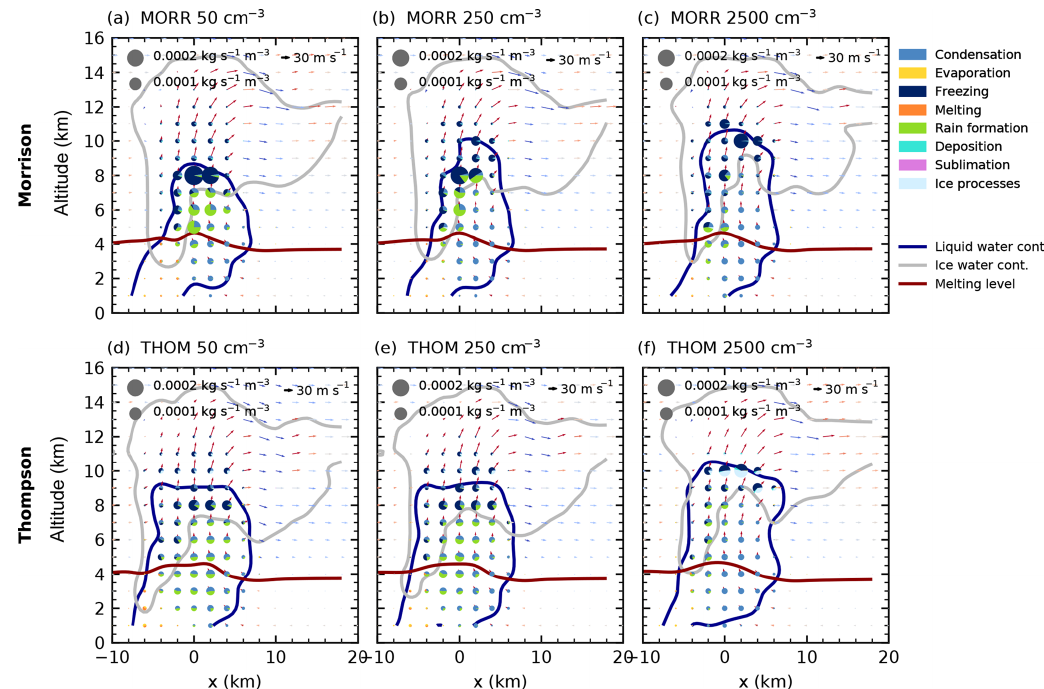
Figure 4. Cloud microphysical morphology along a slice through the cloud parallel to the track of the cell for simulations with three different CDNC values ( a, d : 50cm − 3 , b, e : 2500cm − 3 , c, f : 2500cm − 3 ) after 60min of simulation using the two bulk microphysics schemes ( a–c : Morrison, d–f :